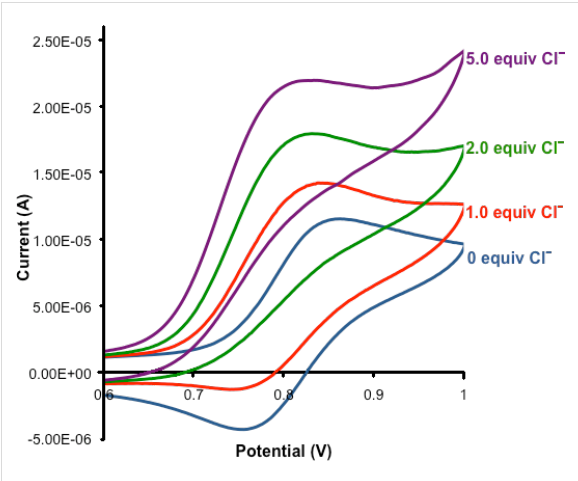
Figure 4: CV of 5 · 2PF 6 upon the addition of TBA·Cl (electrolyte: 0.1 M TBA·PF 6 /CH 3 CN, [ 5·2PF 6 ] = 0.50 mM, 293 K. Potential vs. Ag/AgCl